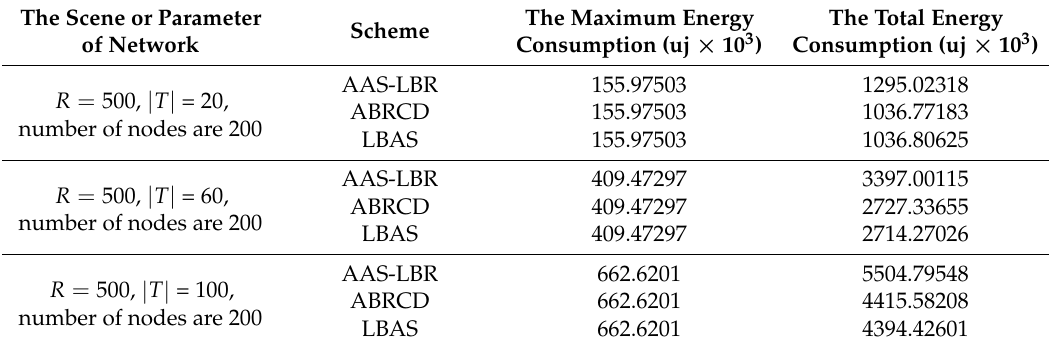
Table 7. The energy consumption